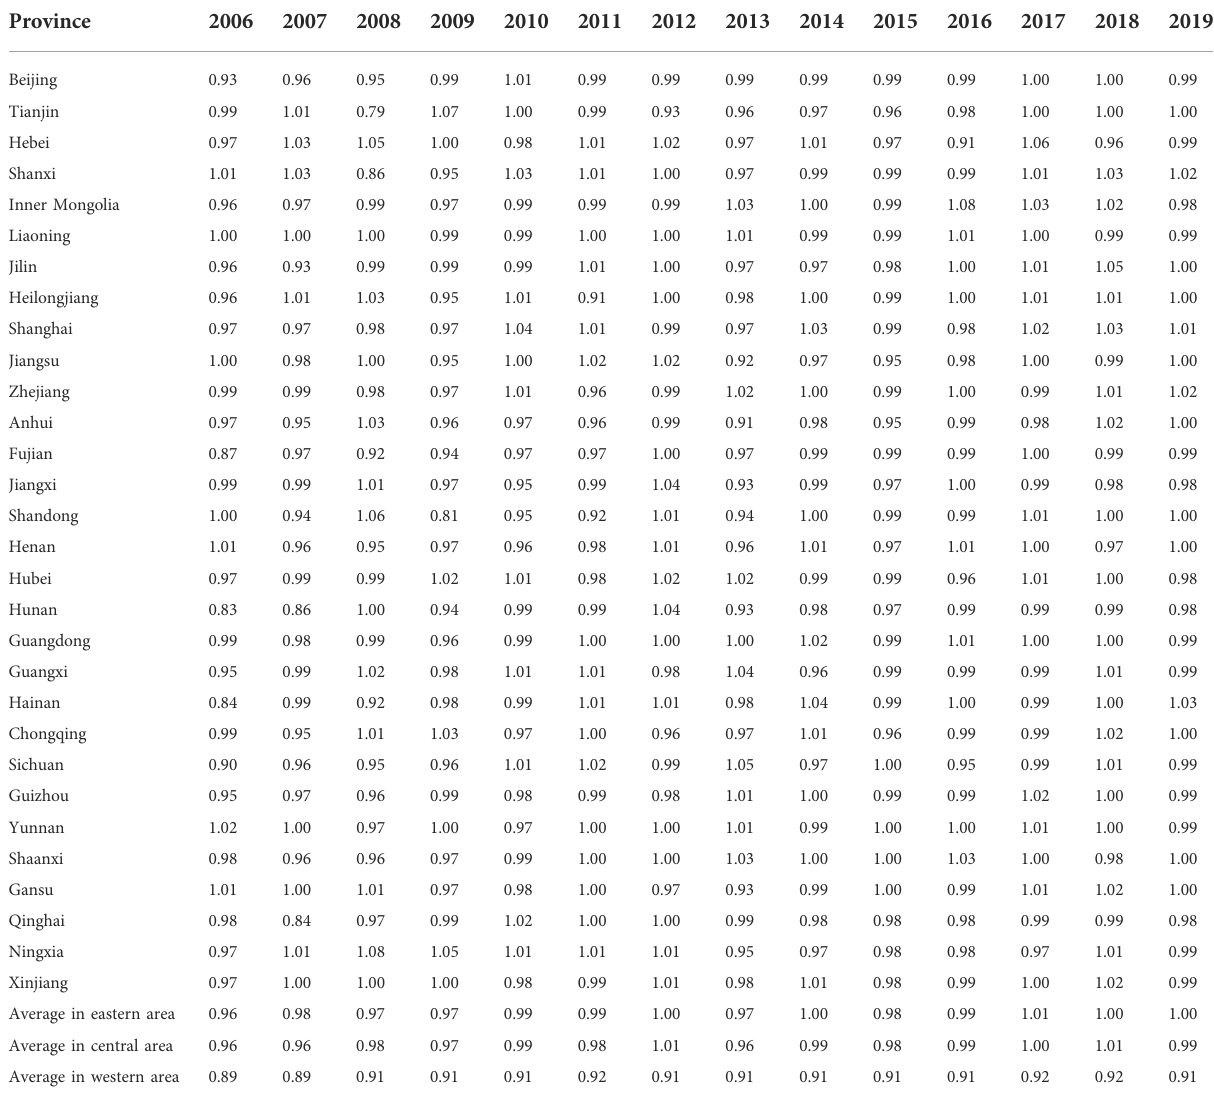
TABLE 2 Green total factor productivity of China ’ s transportation in 2006 – 2019.